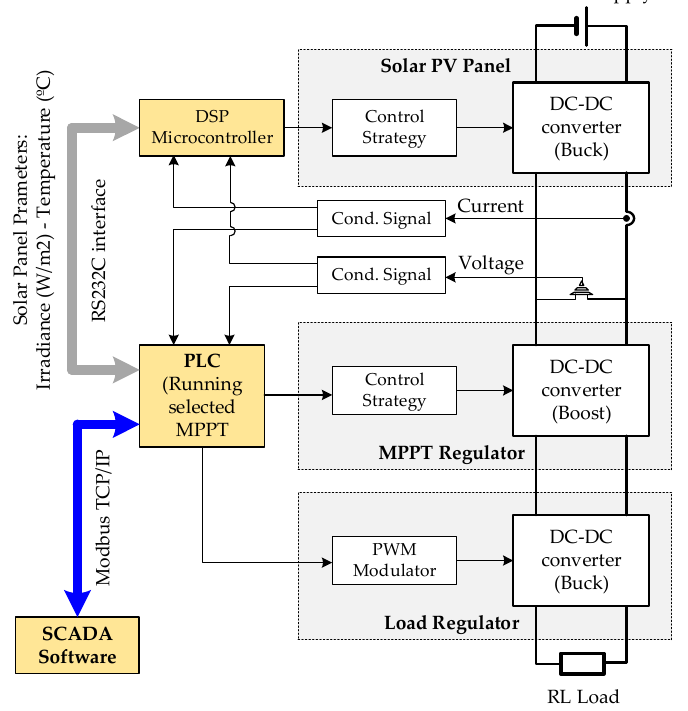
Figure 3. General block diagram of the MPPT test mode (mode II).